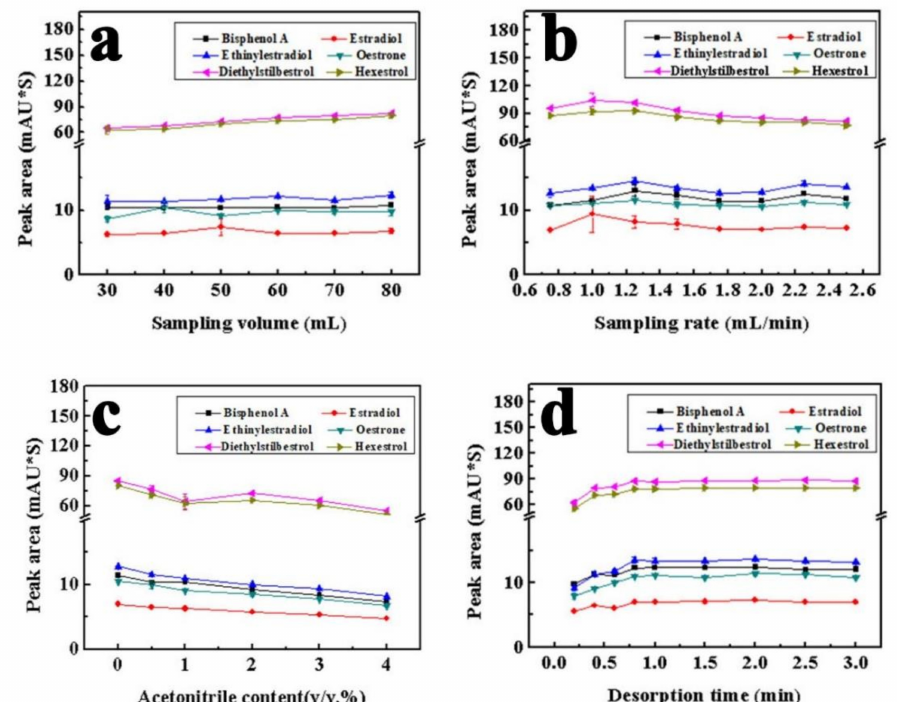
Figure 7. The optimization of extraction conditions using the superhydrophilic fiber as the sorbent for in-tube SPME coupled with HPLC. The concentration of each estrogen is 10 µ g/L. Other experimental conditions are the same as Figure 6. Symbols of ( a – d ) stand for the relationship between the change of peak area with the sampling volume, sampling rate, ACN content and desorption